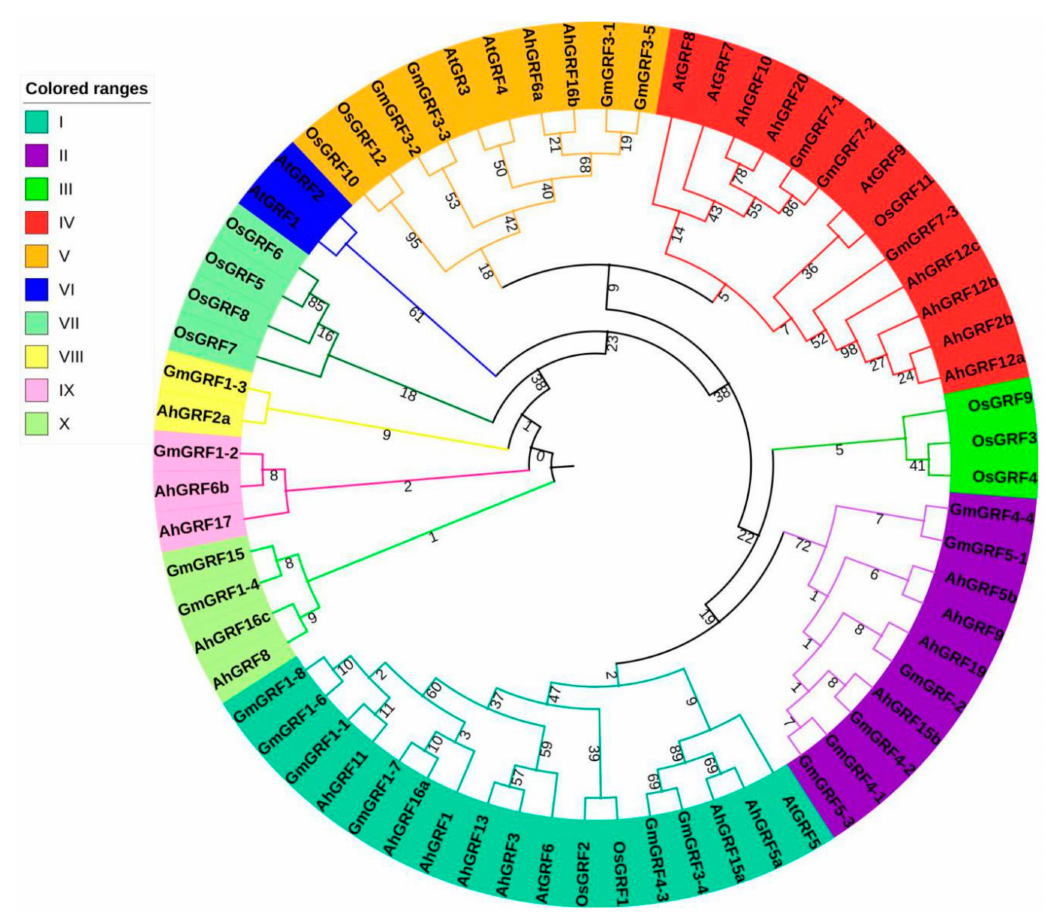
Figure 3. Phylogenetic tree based on the growth regulating factors (GRFs) protein family in four plants. Ah , peanut; At , Arabidopsis thaliana ; OS , rice; Gm , soybean. The number stands for the confidence of the